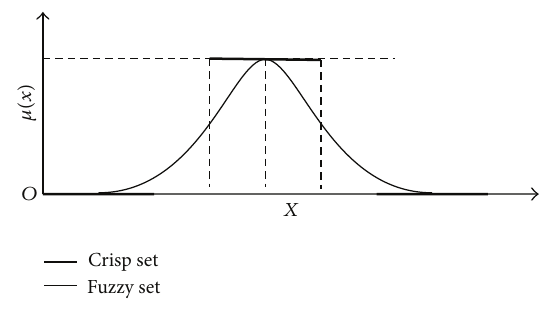
Figure 1: Crisp sets and fuzzy